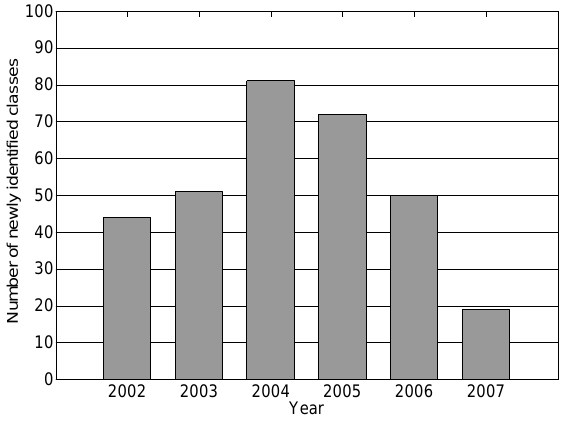
Figure 3. Number of newly two-Euro counterfeit common